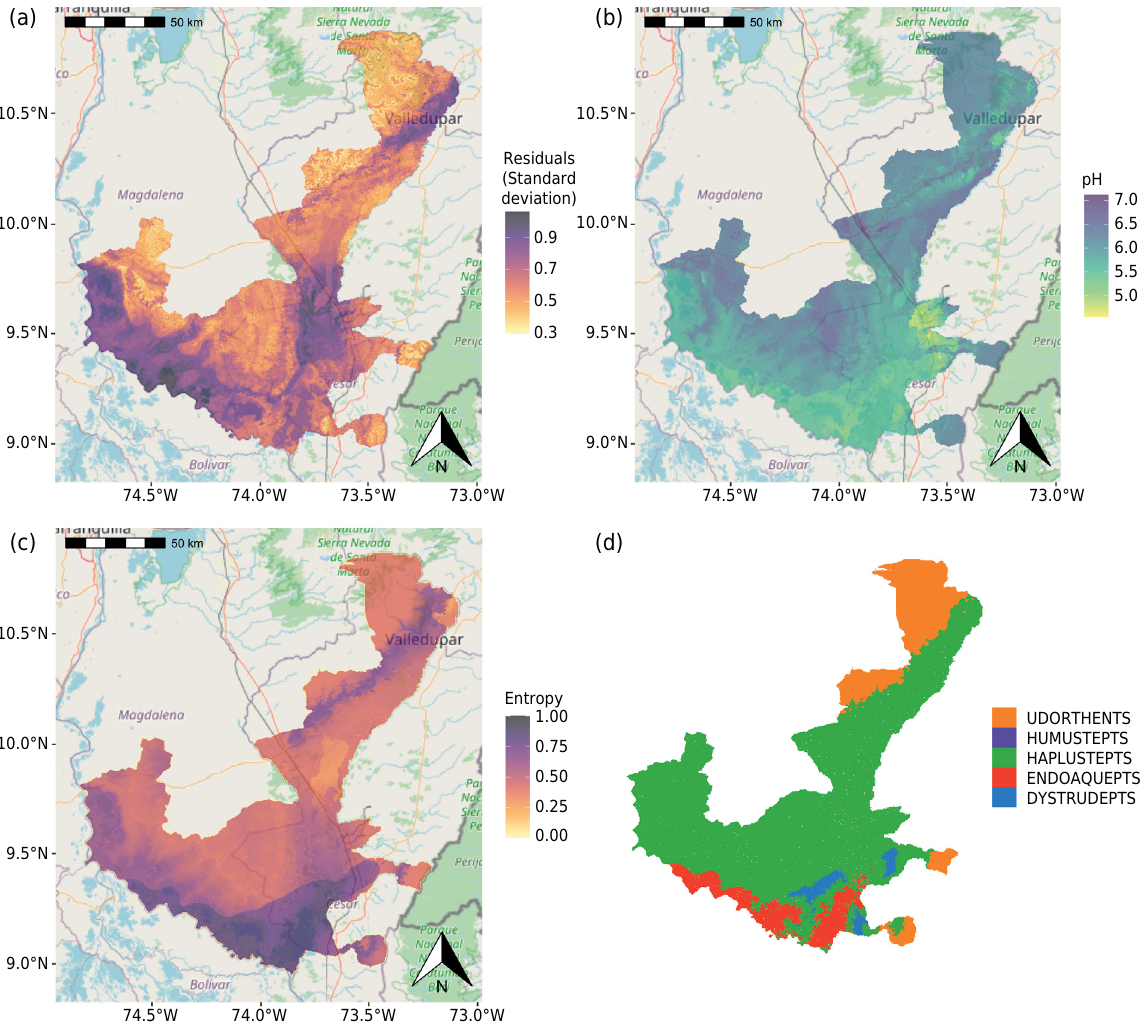
Figure 5. Uncertainty (left) and prediction (right) maps of pH 0.00-0.30 m (a, b) and great groups (c, d). Open Street Map is used as base